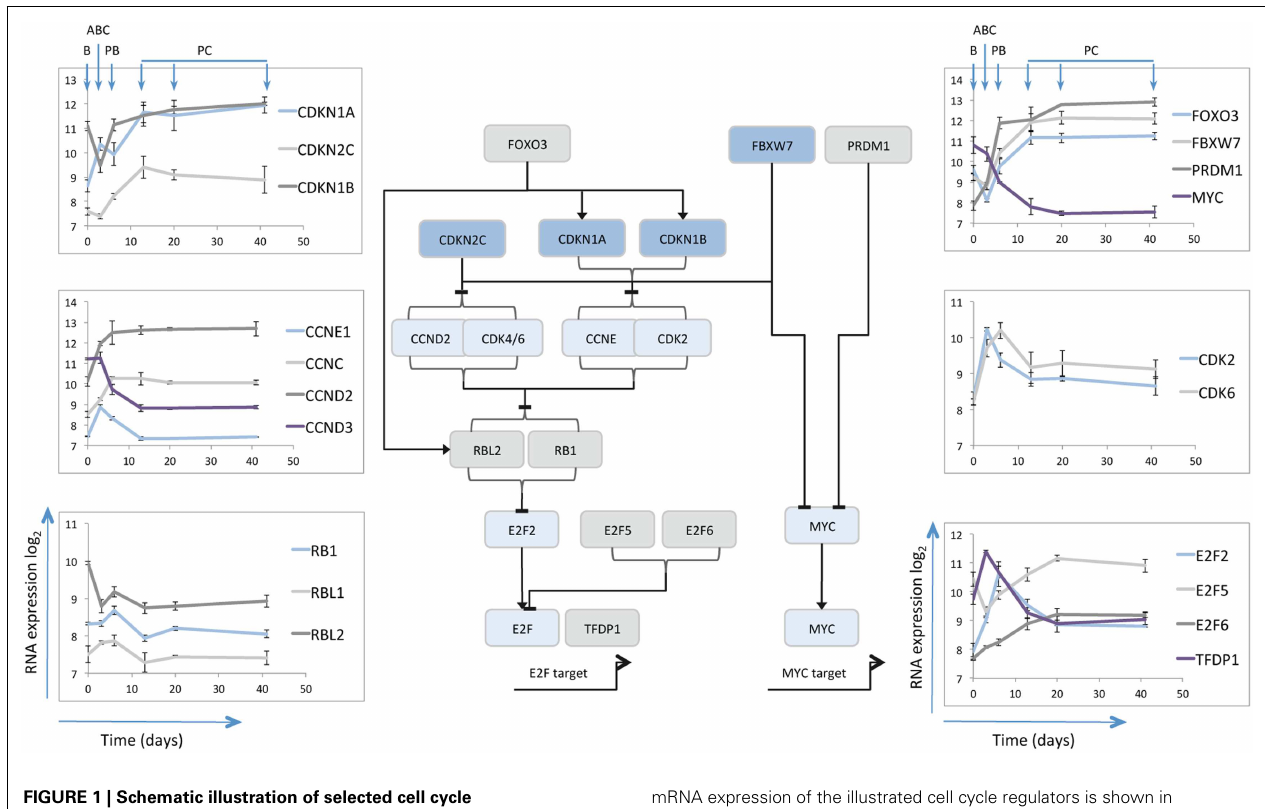
FIGURE 1 | Schematic illustration of selected cell cycle regulators .The central line diagram provides a broad summary of relationships between the selected cell cycle regulators as identified in referenced literature. General positive (arrow heads) and negative (horizontal lines) regulatory interactions are indicated, without specific reference to the nature of the regulatory mechanism.The pattern of